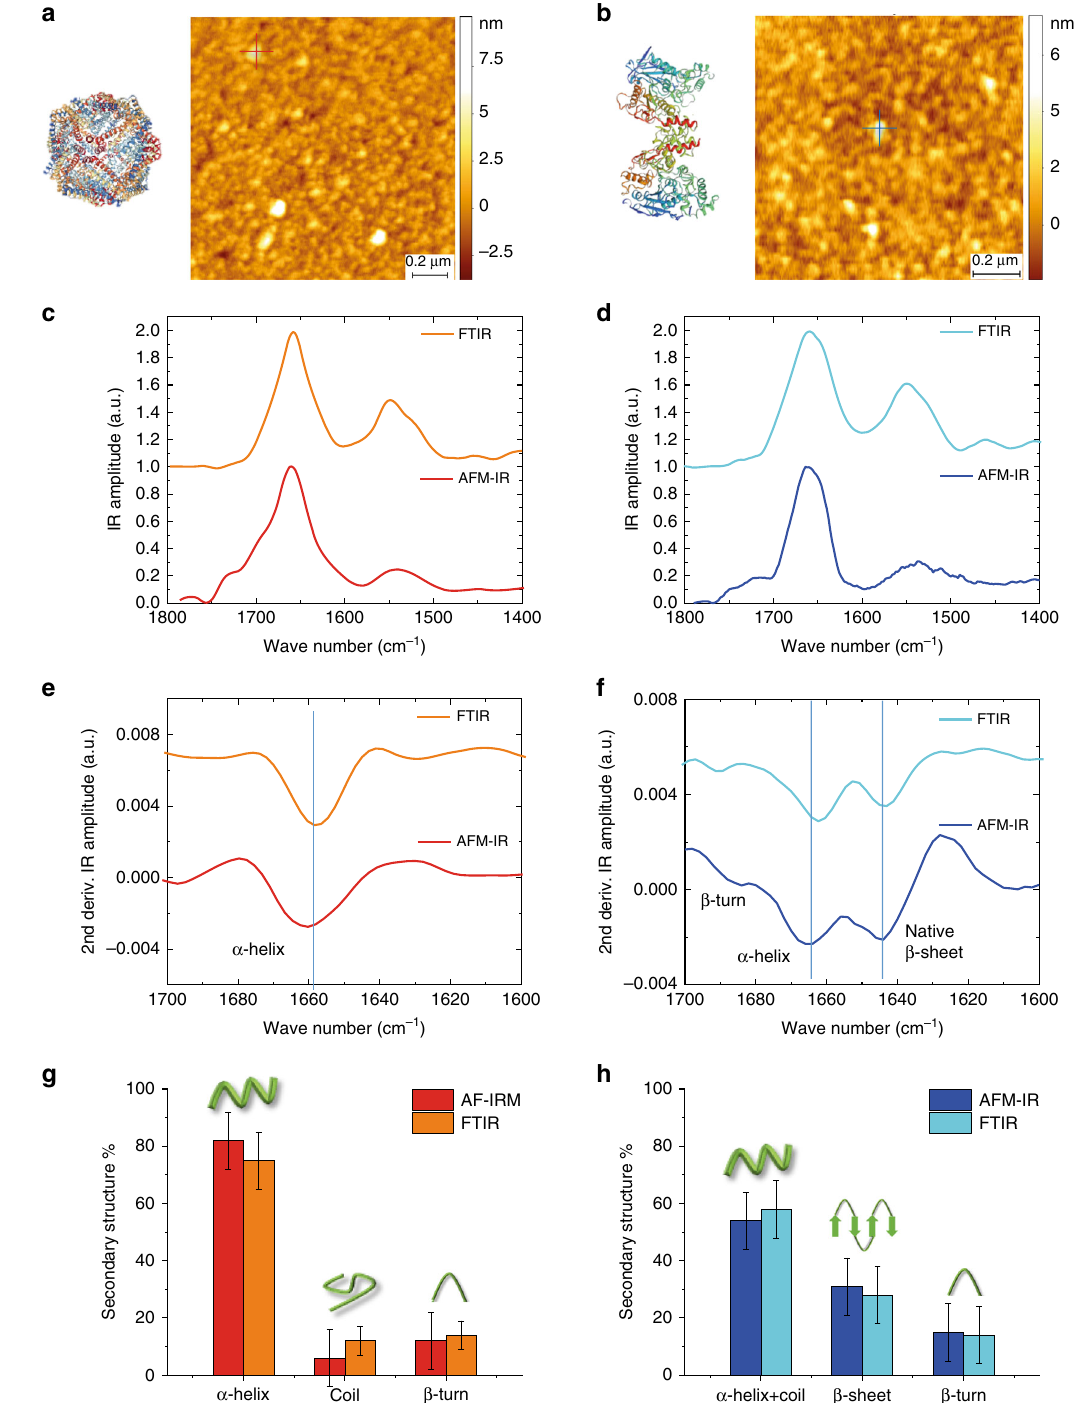
Fig. 4 Secondary structure determination from ORS-nanoIR absorption spectra. Structures and morphologies of a apoferritin 33 (red cross) and b thyroglobulin (blue cross) 29 . c , d Average IR spectrum of three different protein molecules and comparison with bulk IR spectra. e , f Deconvolution of the structural contributions in the amide band I by second-derivative analysis (Savitzky – Golay smoothed, second order, 7 pt) and comparison with bulk FTIR spectra. Comparison of the measured secondary structure by bulk FTIR and single-molecule AFM-IR of g apoferritin and h thyroglobulin. The experimental error arises from the sum of the s.e. of the mean of three spectra averaged and the fi t convolution fi t error. Source data are provided as a Source Data fi FTIR measurements . Attenuated total re fl ection infrared spectroscopy (ATR- 9 points) and then the second derivative was calculated applying a Savitzky – Golay fi lter (second order, 11 points). FTIR) was performed using a Bruker Vertex 70 spectrometer equipped with a diamond ATR element. Spectra were acquired with a concentration of 20 μΜ apoferritin and 12 μΜ thyroglobulin. The resolution was 4cm − 1 and all spectra Circular dichroism measurements . CD experiments were carried out using a were processed using OriginPro software. The spectra were averaged (3 spectra Jasco J-810 spectropolarimeter equipped with a Peltier holder. CD spectra were with 412 co-averages), smoothed applying a Savitzky – Golay fi lter (second order, measured at a protein concentration of 1 and 0.25 μΜ of apoferritin and